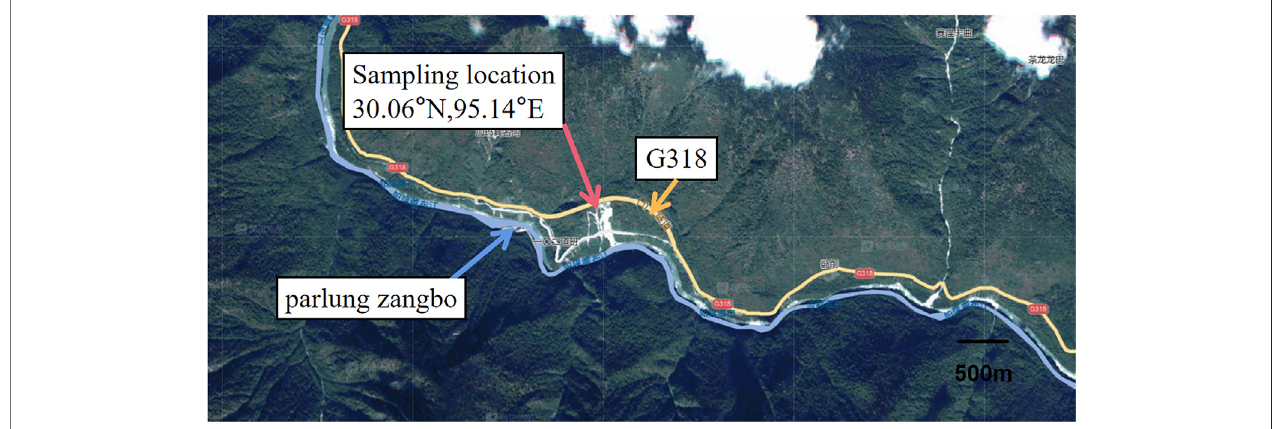
FIGURE 1 | Sampling